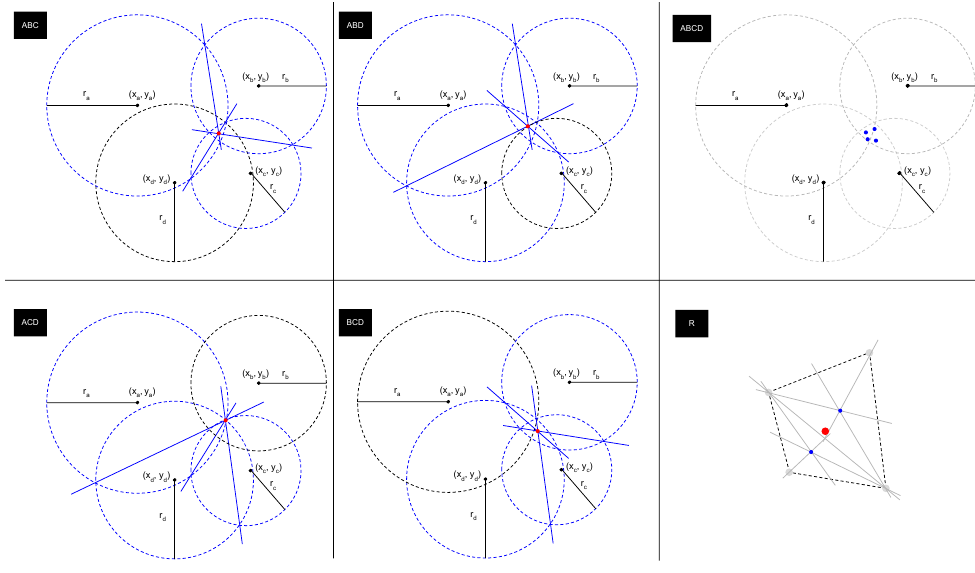
Figure 2. Case: 4 or more detected